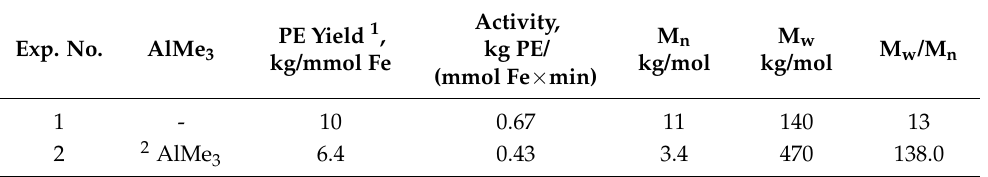
Table 1. Data on the effect of the addition of AlMe 3 into polymerization with the catalyst *LFeCl 2 /MMAO on the molecular weight and molecular weight distribution of produced PE.